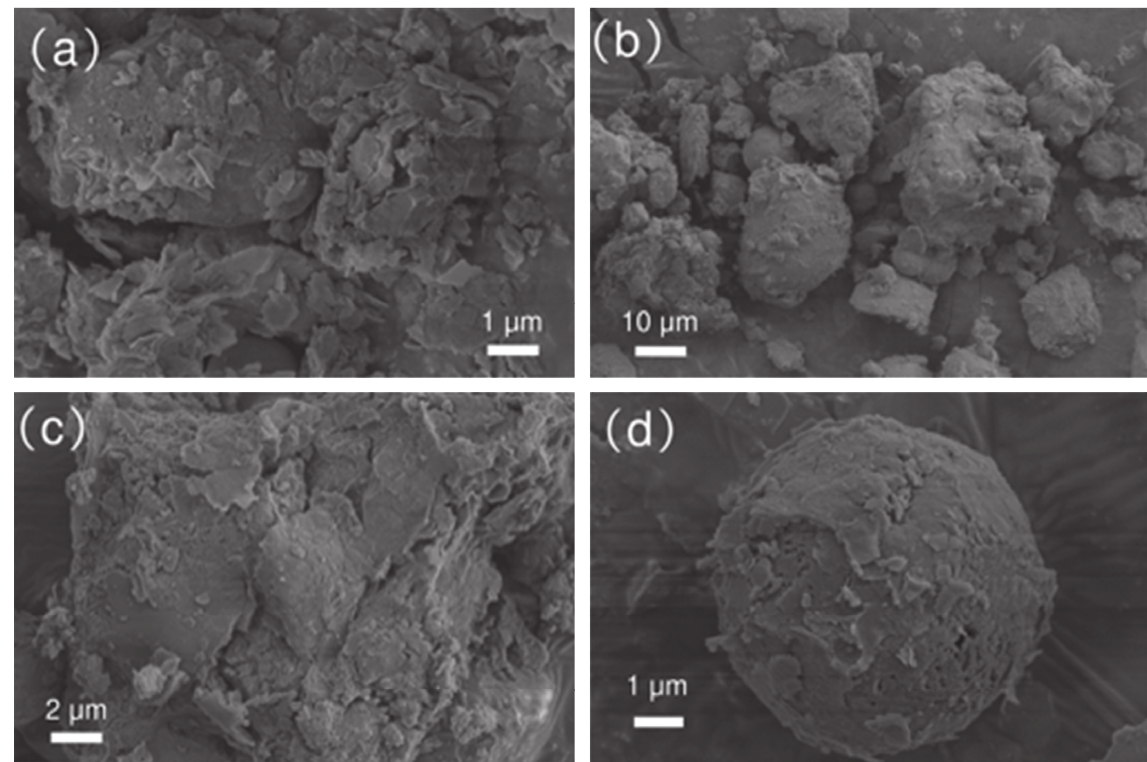
Figure 8: Different scale of SEM images of geopolymer sample: (a) the soil particle and fly ashes are strengthened by flocculence; (b) 10-time zoomed out view of (a); (c) the materials that were not involved in the chemical reaction, which are filler and skeleton of geopolymer sample; (d) typical fly ash particle after the reaction with structural holes on the surface.